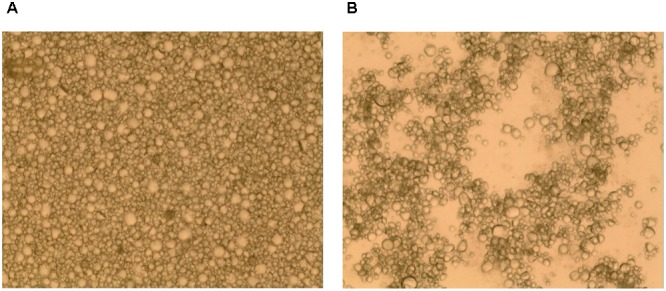
Optical micrograph of starch granule aggregation. Sweet potato starch milk before (A) and after (B) the addition of L. paracasei subsp. paracasei L1 cultures (100×).